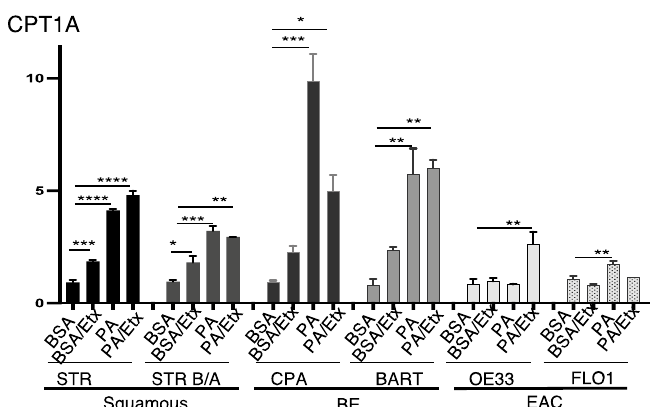
Figure 5. PA stimulates IL1B, IL8 and CPT1A and upregulation in the progression to EAC. RNA expression was determined by qRT-PCR with primers for the inflammatory cytokines IL1B and IL8 and CPT1A. ( a ) Palmitic acid increased the expression of IL1B in bile/acid-tolerant STRs and BAR-T cells. Etomoxir only inhibits PA-dependent increased expression in BAR-T. ( b ) IL8 expression is increased in a PA-dependent manner in BE cell lines and inhibited by etomoxir. ( c ) CPT1A is increased in response to PA stimulation in STR, CPA, and BAR-T cells. Etomoxir only reverses the increase in CPA cells. * p < 0.05, ** p < 0.01, *** p < 0.001, **** p < 0.0001, One-way ANOVA.